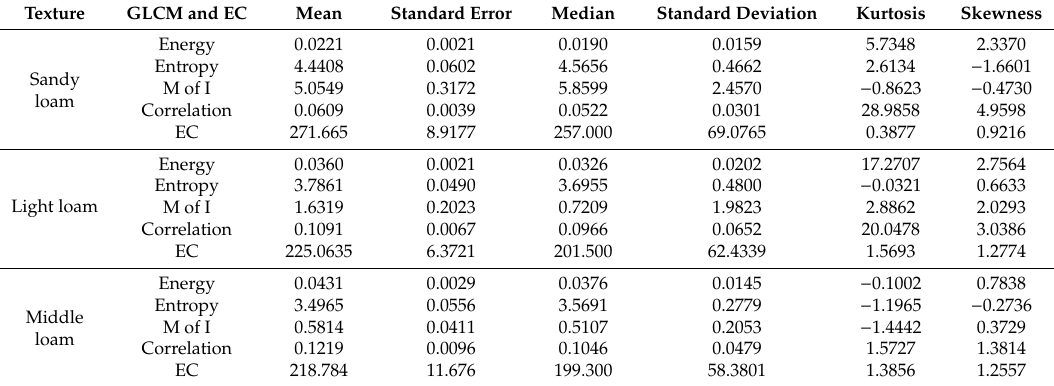
Table 2. Sample descriptive statistics table. GLCM—gray level co-occurrence matrix